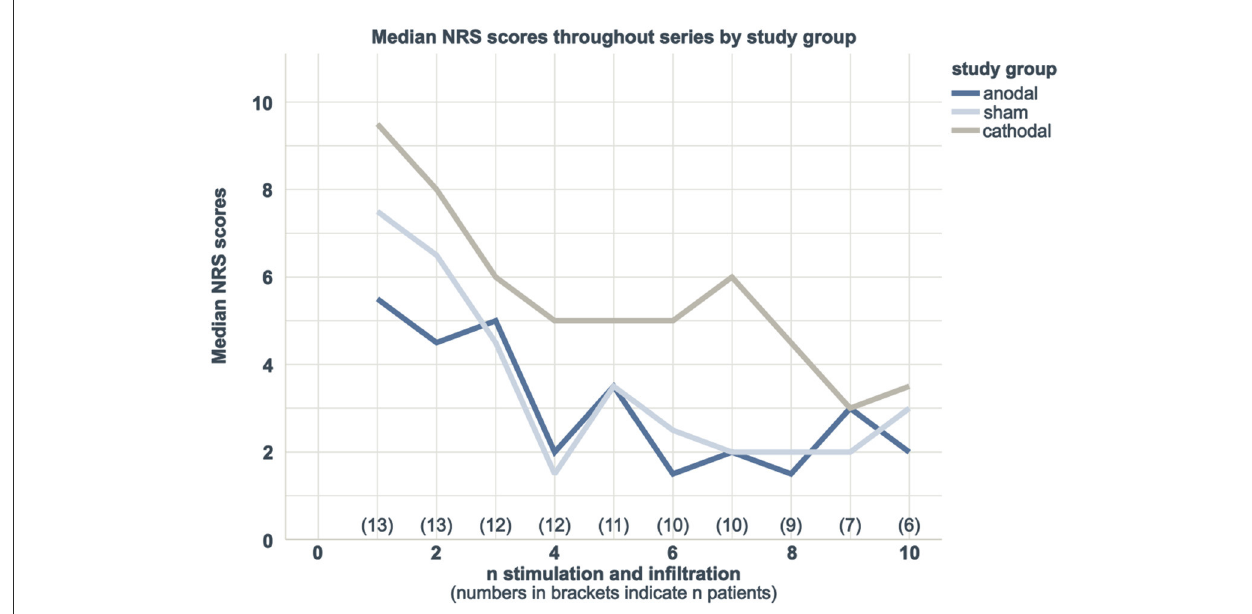
FIGURE3 Course of median NRS max values throughout series by study group.